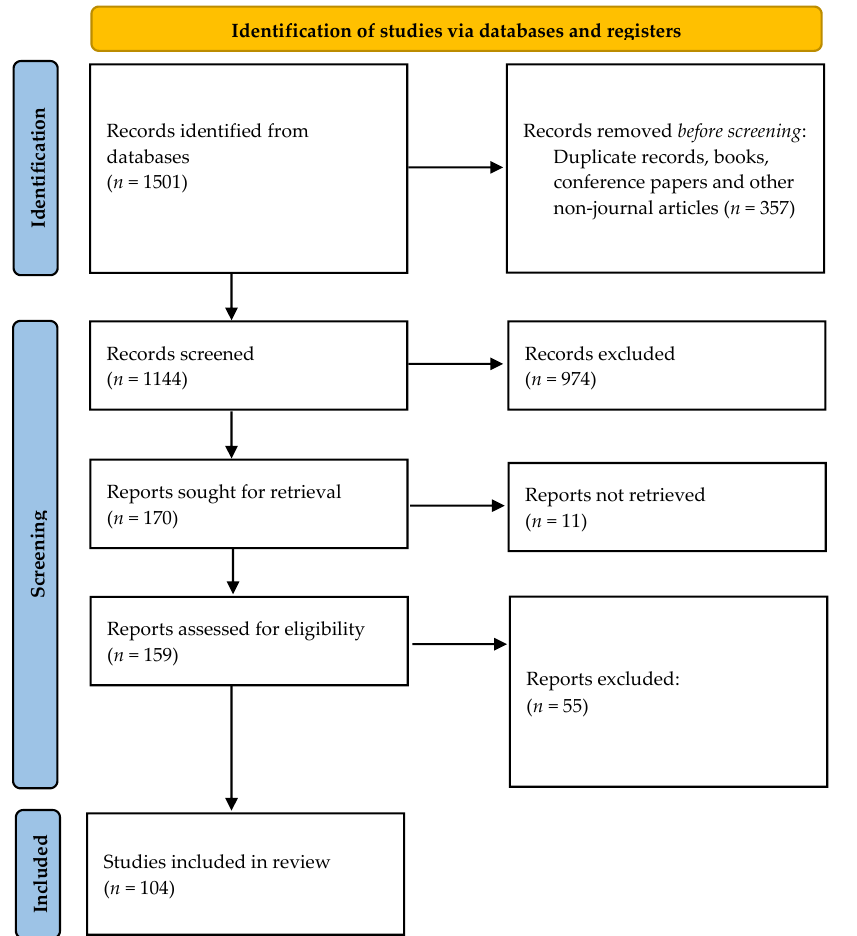
Figure 1. PRISMA diagram of search and review process.